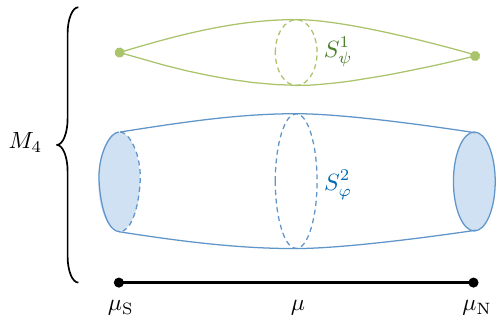
, and , the circle S 1 ϕ ψ . The blow-up P 1 ’s are identified 2